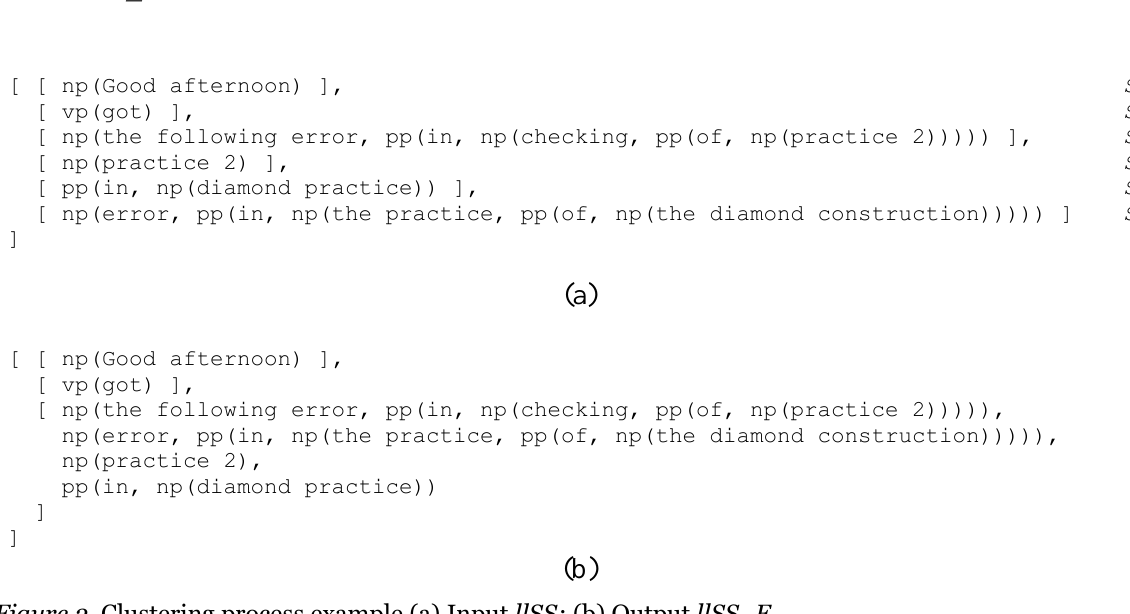
Figure 2. Clustering process example (a) Input llSS; (b) Output